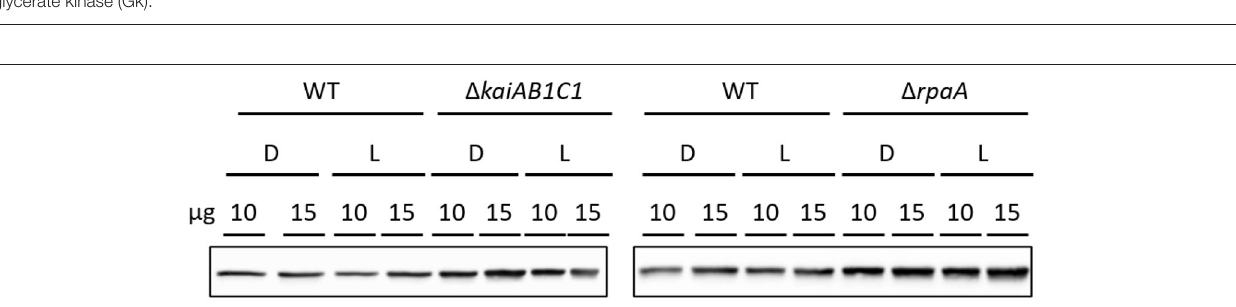
lower glycolysis may be controlled via the newly discovered PII-regulated switch of phosphoglycerate mutase (PGAM) activity via PirC (Orthwein et al., 2021). Previous gene expression